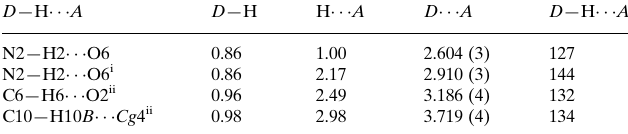
Hydrogen-bond geometry (A˚ , (cid:2) ). Cg 4 is the centroid of the C2–C7